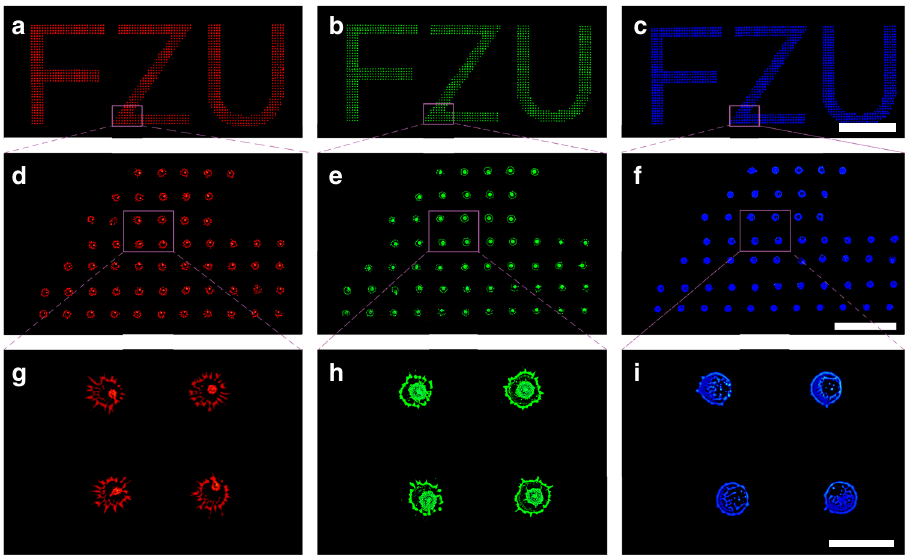
Fig. 3 Security labels with physically unclonble fl ower-like patterns. Typical fl uorescence images of inkjet-printed macroscopic letters FZU composed of a red, b green, and c blue emission dot patterns (the scale bar is 4000 μ m), d – f their local enlarged images (the scale bar is 500 μ m), and g – i further enlarged images (the scale bar is 100 μ m). All the samples are printed under the same conditions. The FZU patterns are identical on macroscale but completely different at the microscale (i.e., every dot pattern is